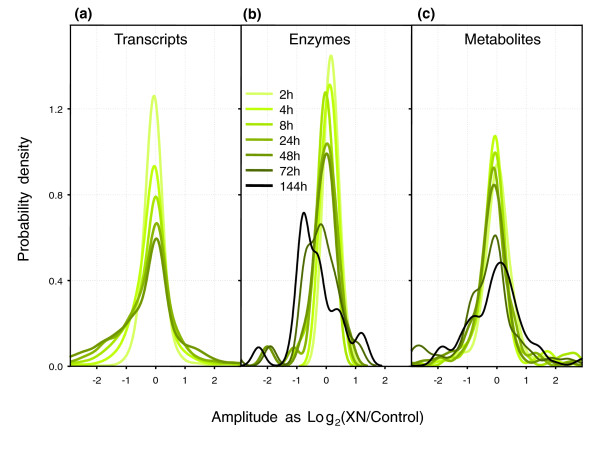
Distribution of global changes in transcript and metabolite levels and enzyme activities during the diurnal cycle and an extended night (XN). Distribution of changes in (a) 2,433 transcripts assigned to metabolism, (b) 23 enzyme activities and (c) 140 metabolites after 2, 4, 8, 24, 48, 72 and 144 h of extension of the night. Transcript levels were not determined at 72 and 144 h. Distributions are expressed as probability densities and were calculated with R using the function 'density', which computes kernel density estimations. The same bandwidth of 0.2 was used for all datasets.